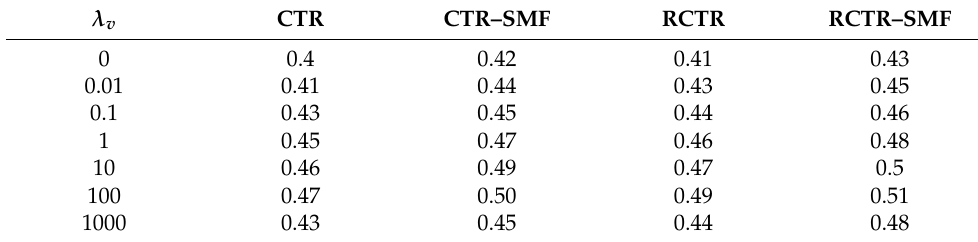
Table 4. Recall comparison of CTR, CTR–SMF, RCTR and